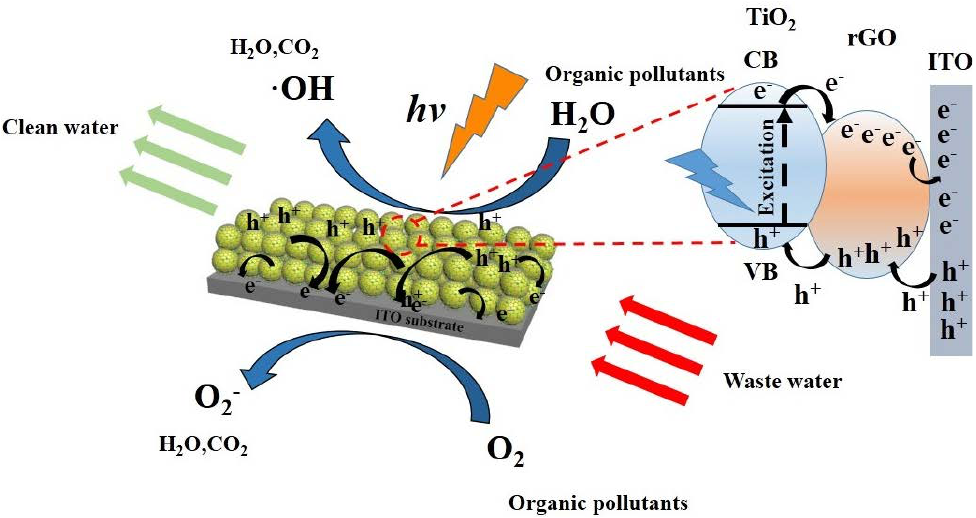
Figure 12. Schematic mechanisms of MB decomposition through photodegradation by ITO-rGO and TiO 2 .